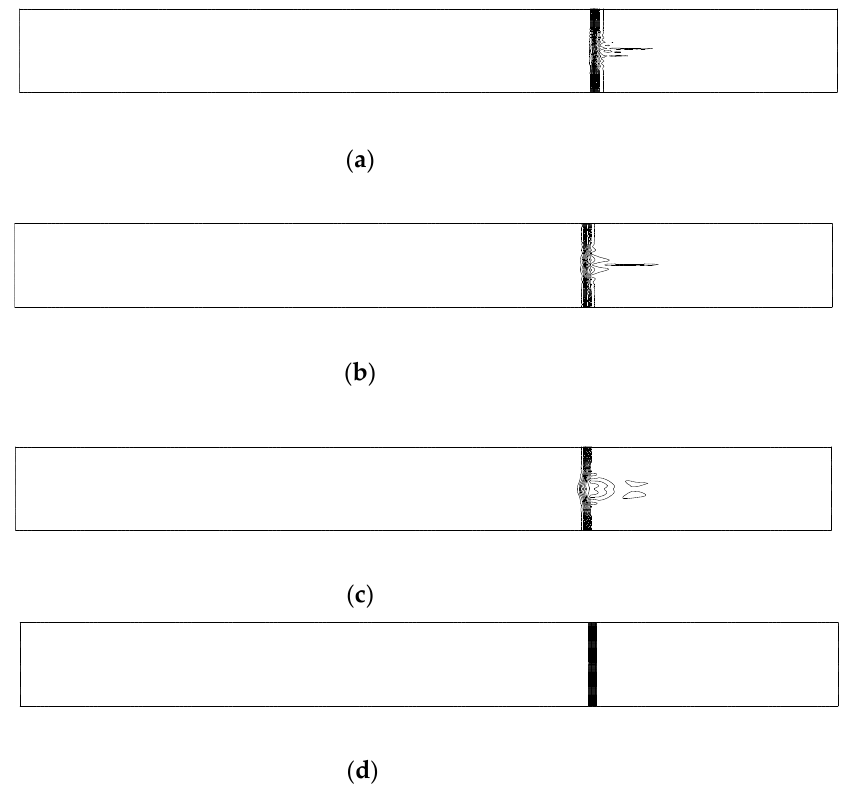
Figure 16. Density contours of the odd–even grid perturbation problem ( M s = 6.0, first order reconstruction, ∆ x = 1); ( a ) AUSM+; ( b ) AUSMPW+; ( c ) SLAU; ( d )